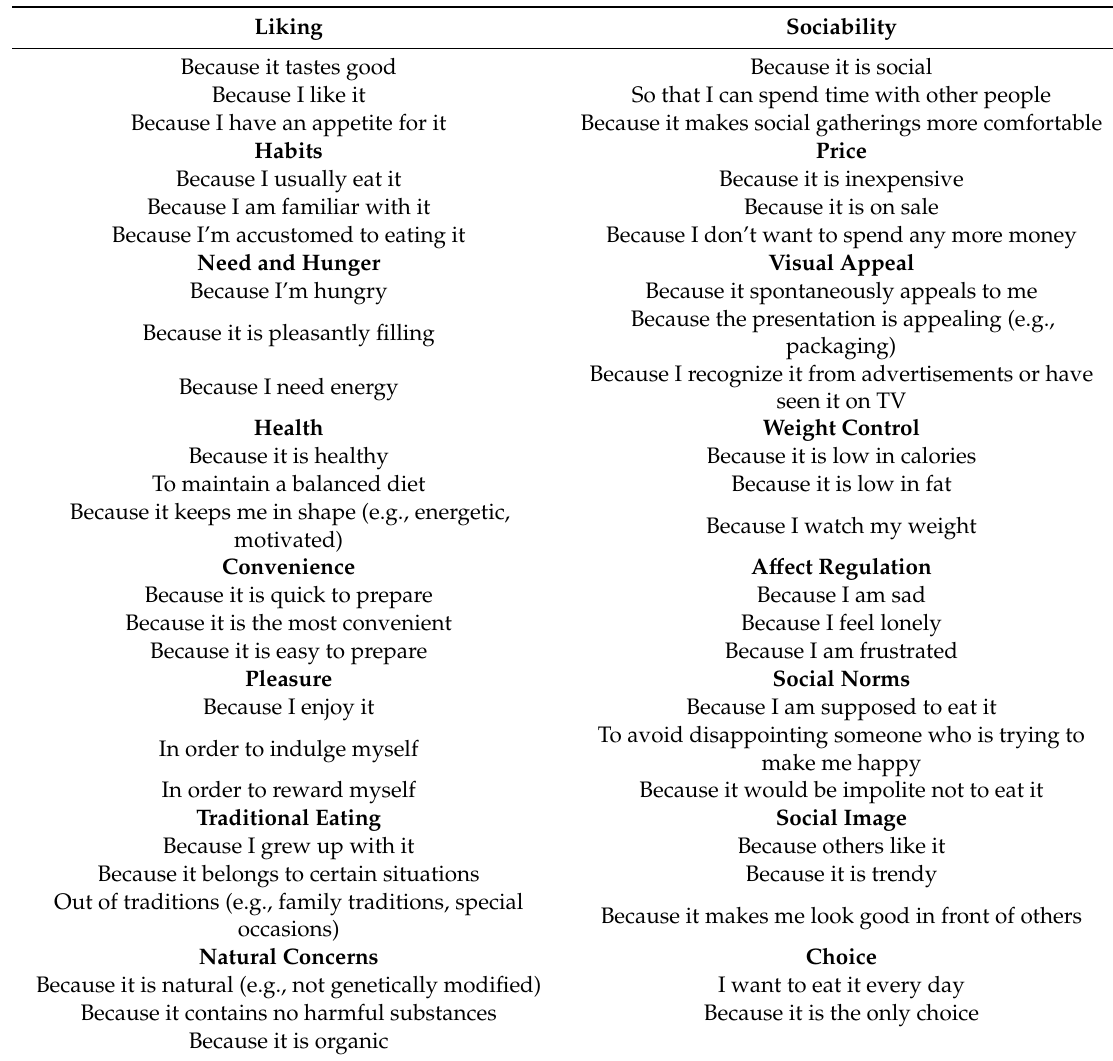
Table 2. 16 eating motivation constructs and their corresponding positive sub-items that were used in the Eating Motivation Survey